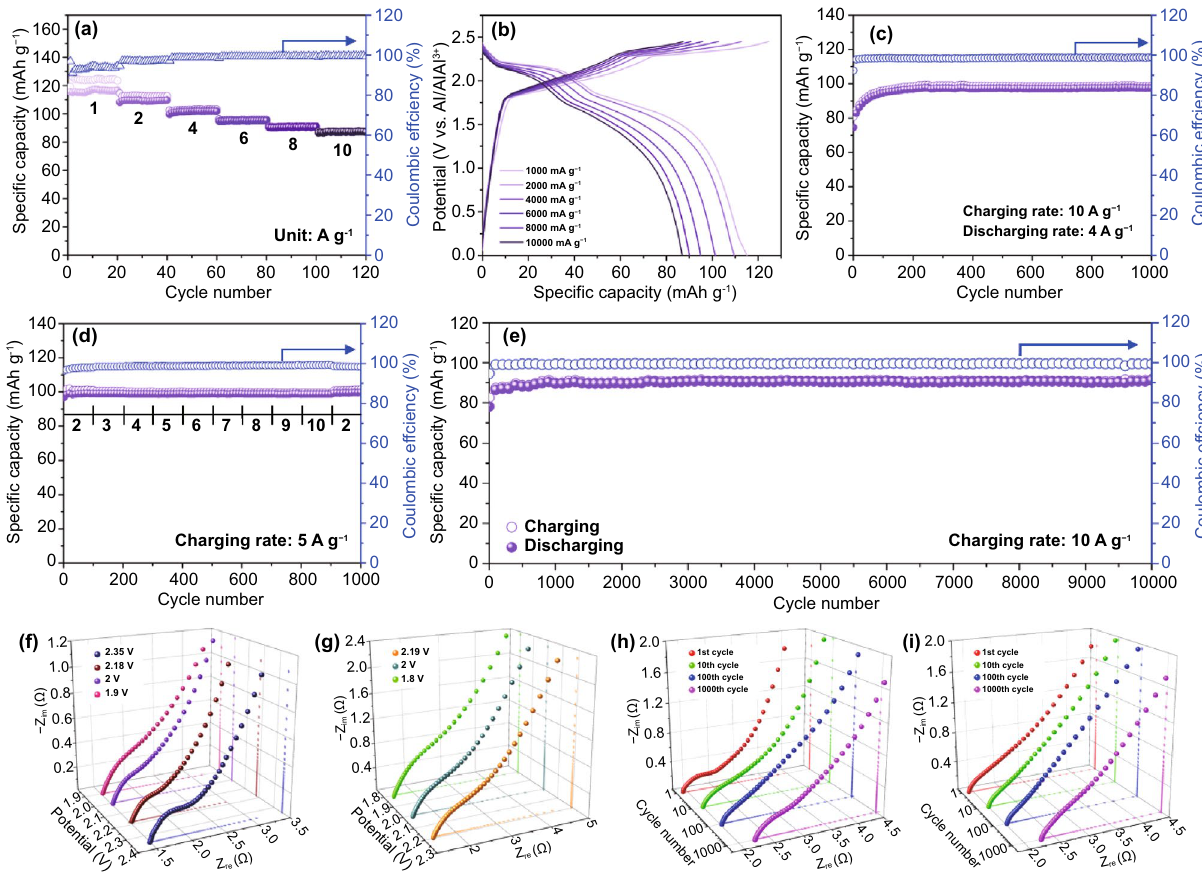
Fig. 5 Electrochemical performance of the BEG cathode. a Rate performance for each current density and b the corresponding charge–dis- charge voltage profiles of a . c Cyclic stability at the fast charging rate of 10 A g −1 and slow discharging rate of 4 A g −1 over 1000 cycles, d Rate capability at a constant charging rate of 5 A g −1 with various discharging rates, and e Ultralong-term cyclic stability at a fast current density of 10 A g −1 over 10,000 cycles. Nyquist plots for various f oxidation potentials (intercalation) and g reduction potentials (de-intercalation) and cycled electrodes at h an oxidation potential of 2.35 V and i Reduction potential of 2.19